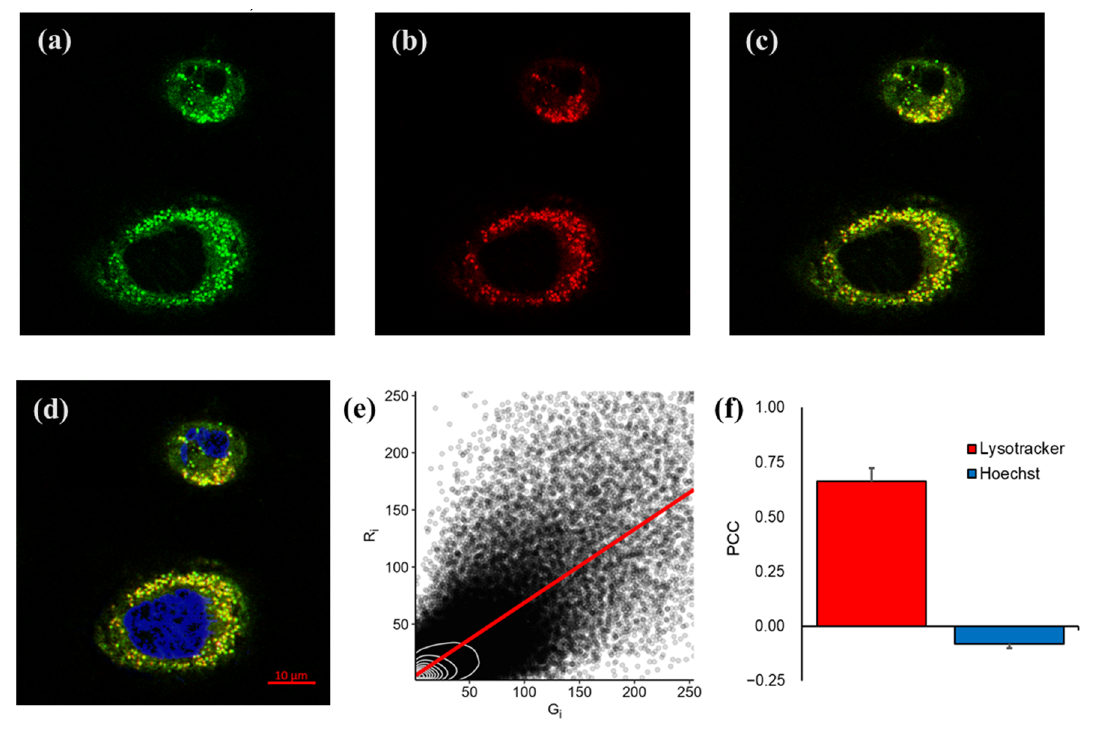
Figure 6. ( a ) Confocal fluorescence images of HeLa cells treated with BODIPY 3 and ( b ) Lysotracker Deep Red. ( c ) Merge of BODIPY fluorescence signal (green channel, λ ex 488 nm) and Lysotracker fluorescence signal (red channel, λ ex 633 nm). ( d ) Merge of Hoechst 33342 fluorescence signal (blue channel, λ ex 405 nm), BODIPY 3 fluorescence signal (green channel) and Lysotracker fluorescence signal (red channel). ( e ) Scatterplot of the pixel intensity for red (R i ) and green (G i ) channels. ( f ) Pearson’s correlation coefficient (PCC) of BODIPY with Lysotracker and Hoechst 33342 dye.